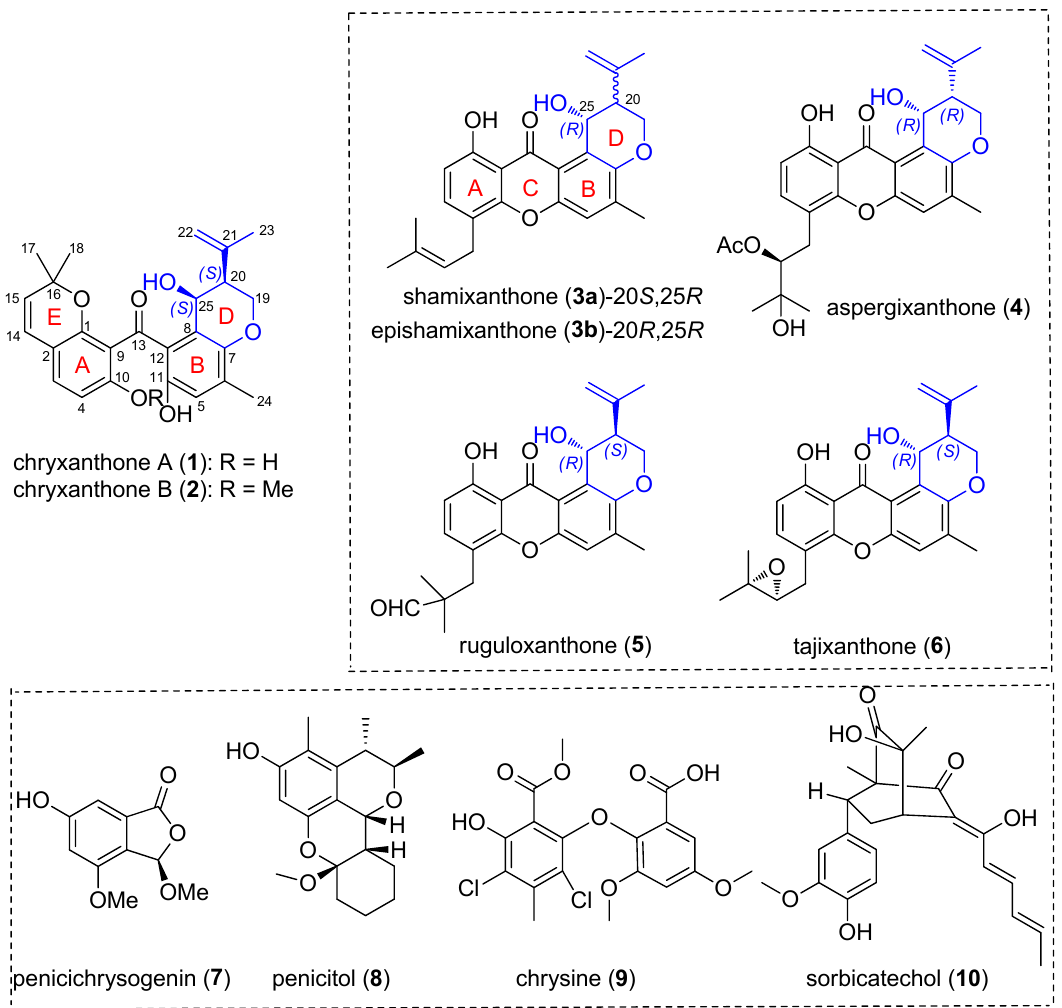
Figure 1. The structures of chryxanthone A ( 1 ) and B ( 2 ) and previously reported compounds, shamixanthone ( 3a ), epishamixanthone ( 3b ), aspergixanthone ( 4 ), ruguloxanthone ( 5 ), tajixanthone ( 6 ), penicichrysogenins ( 7 ), penicitols ( 8 ), chrysines ( 9 ), and sorbicillinoids ( 10 ).